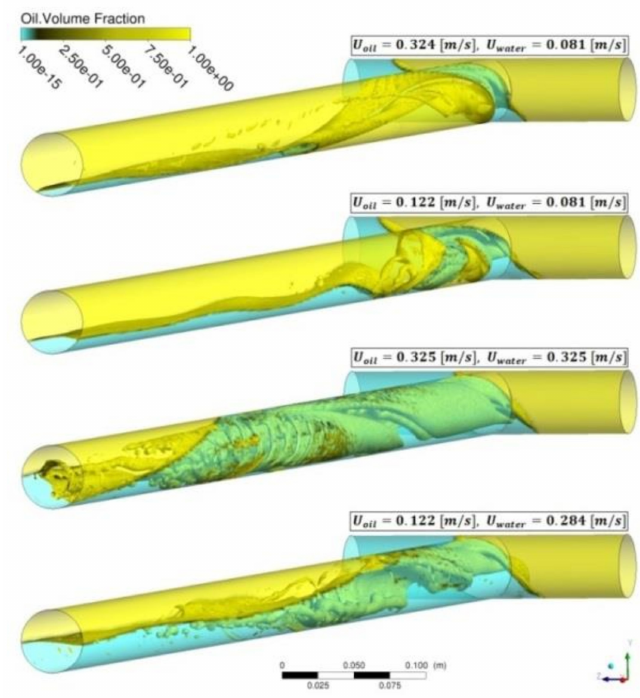
Figure 10. Oil volume fraction and isosurface of the oil throughout the domain at di ff erent oil and water entry